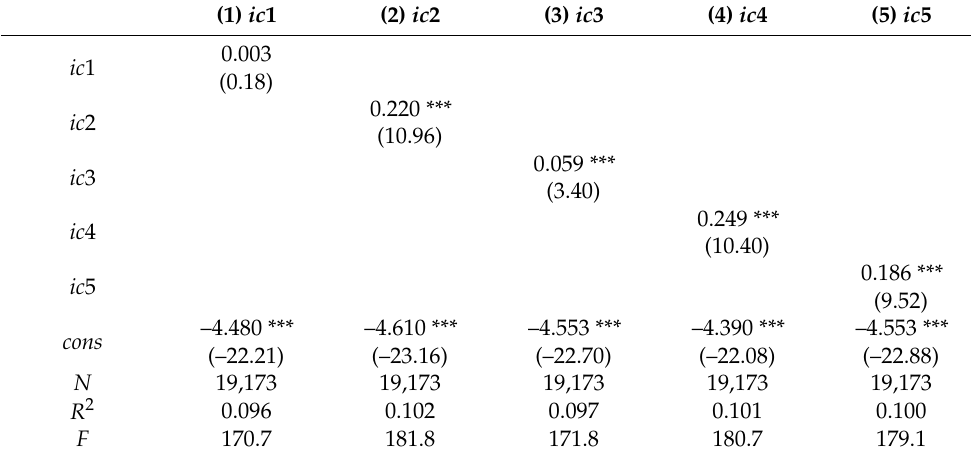
Table 4. Impact of the five elements of internal control on green